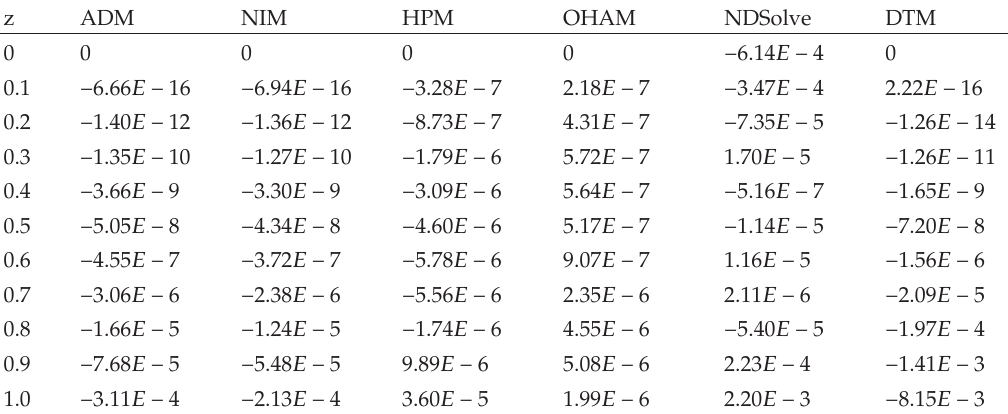
Table 2: Comparison of residuals. In this table residuals of all the techniques at the di ff erent domain points are displayed. We observe that OHAM provides more stable